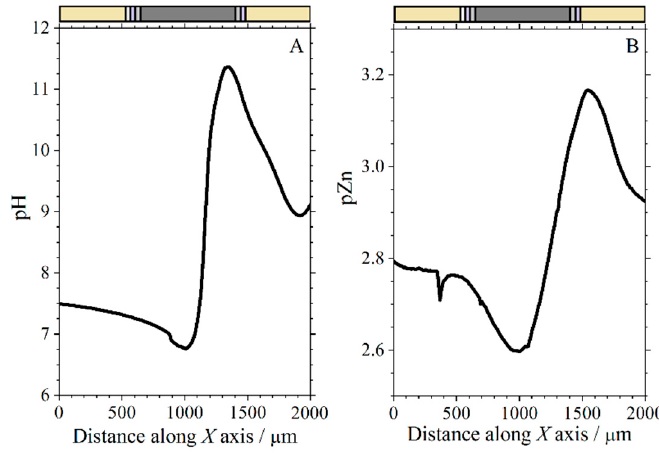
Figure 13. Line scans with pH-sensitive antimony electrode ( A ) and Zn 2+ -ISME ( B ) above the cut edge of painted galvanized steel (corresponding to sketch #1 in Figure 1C) immersed in 1 mM NaCl solution. The line scans were recorded in separate measurements.